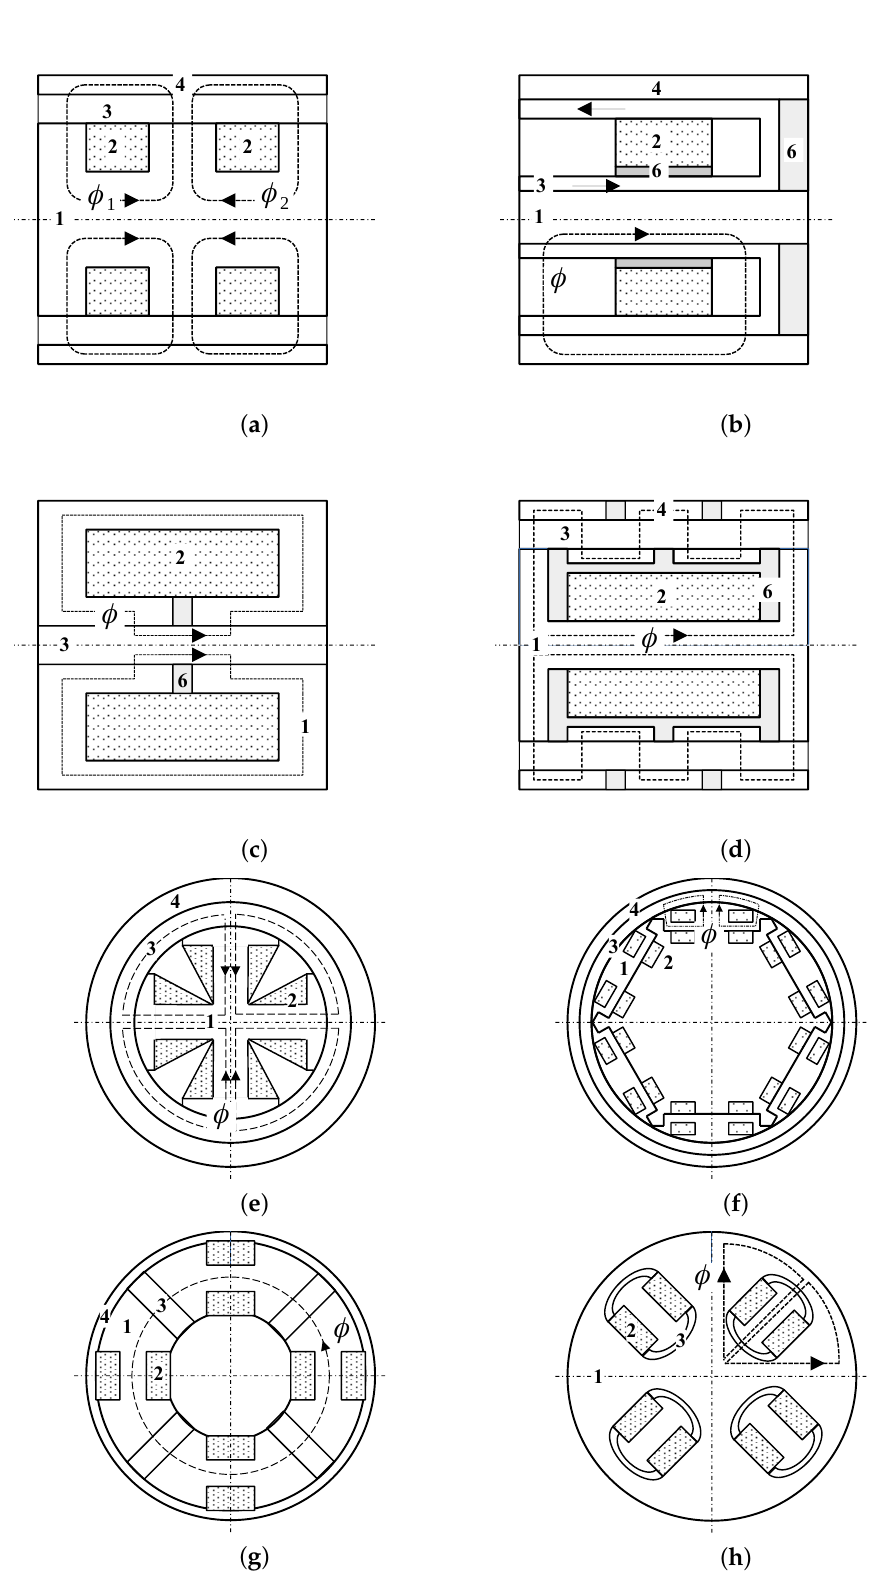
Figure 8. MR valves: configurations (continued), 1—core, 2—coil(s), 3—primary flow path(s),